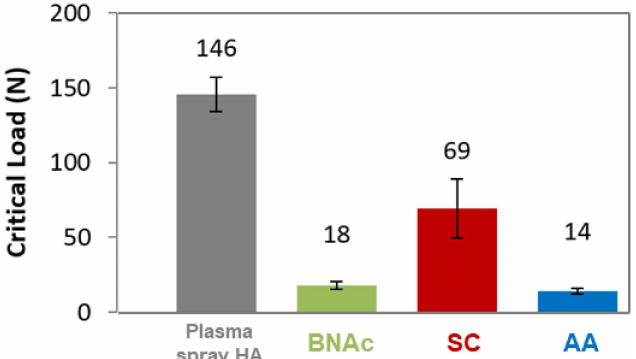
Figure 10. Bending test coating critical load.